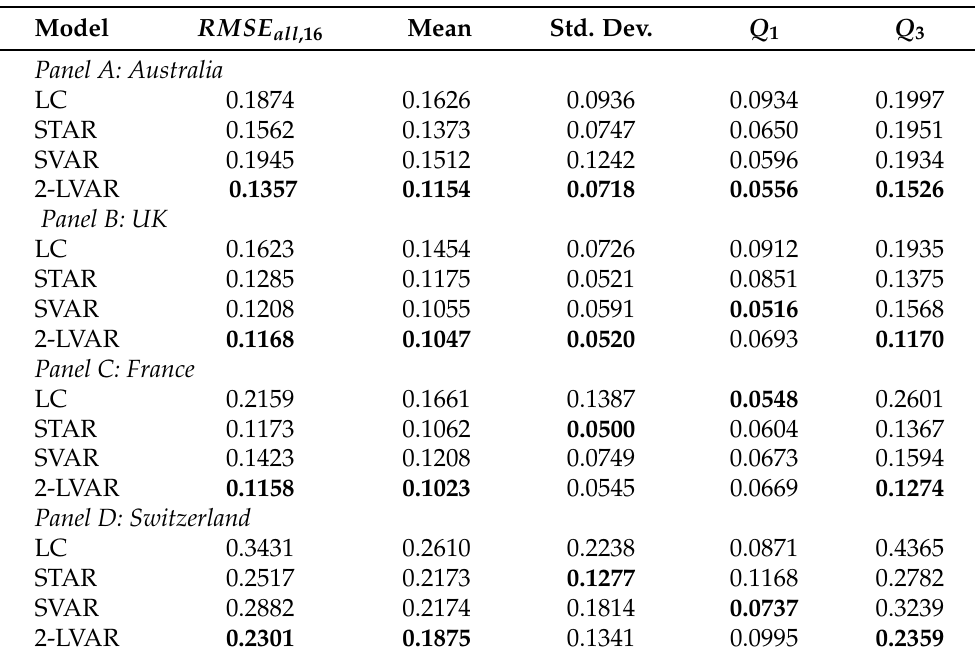
Table 1. Summary of overall RMSE over age